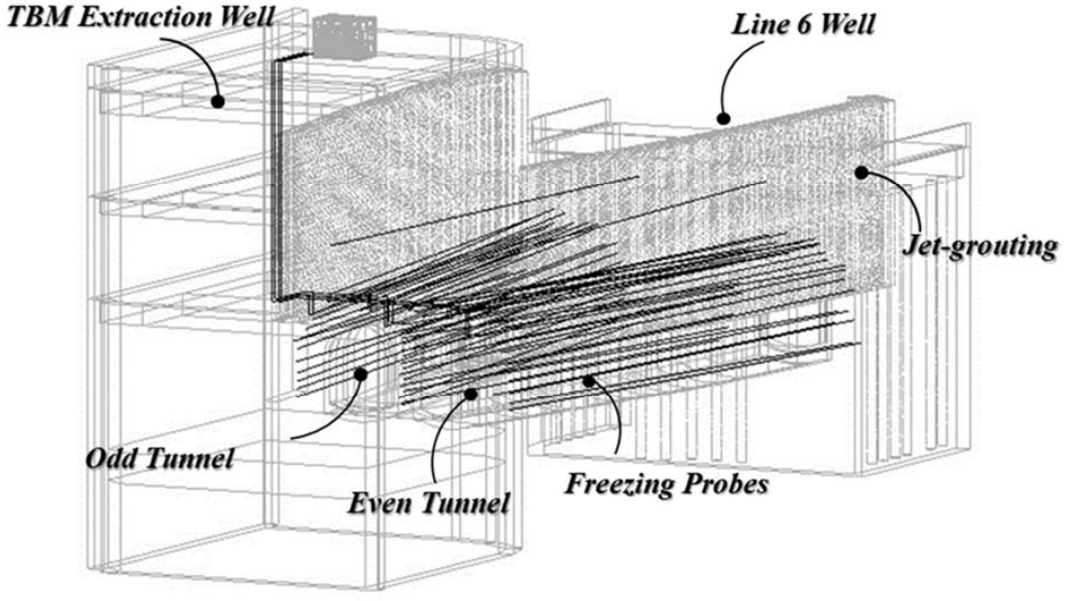
Figure 4. Axonometry of the two tunnels connecting Line 1 and Line Figure 4 . Axonometry of the two tunnels connecting Line 1 and Line 6.